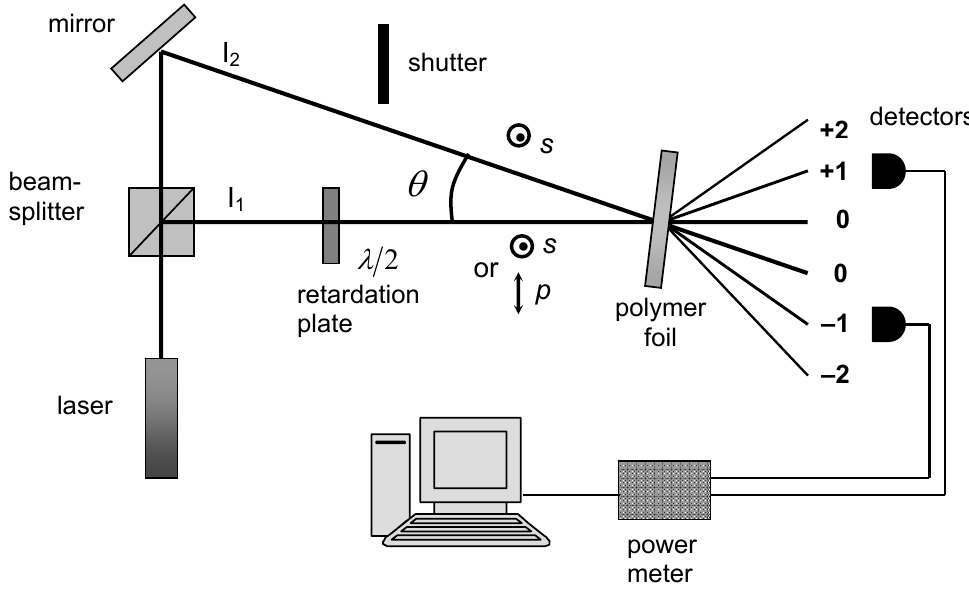
Fig. 2 Degenerate two-wave mixing experimental set-up with the possibility of s − s and s − p polarization grating recording and kinetics measurements, λ = 514.5